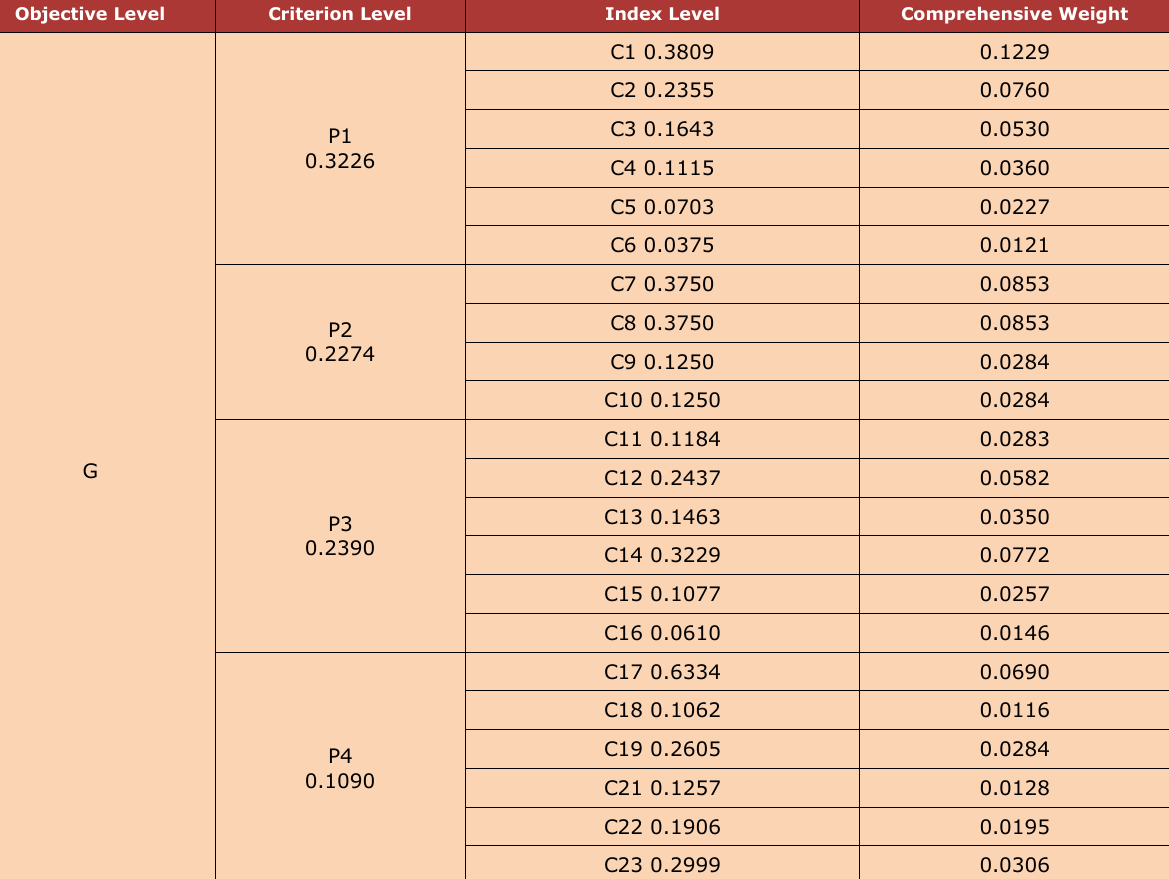
Table 4. Weight Assignment of All